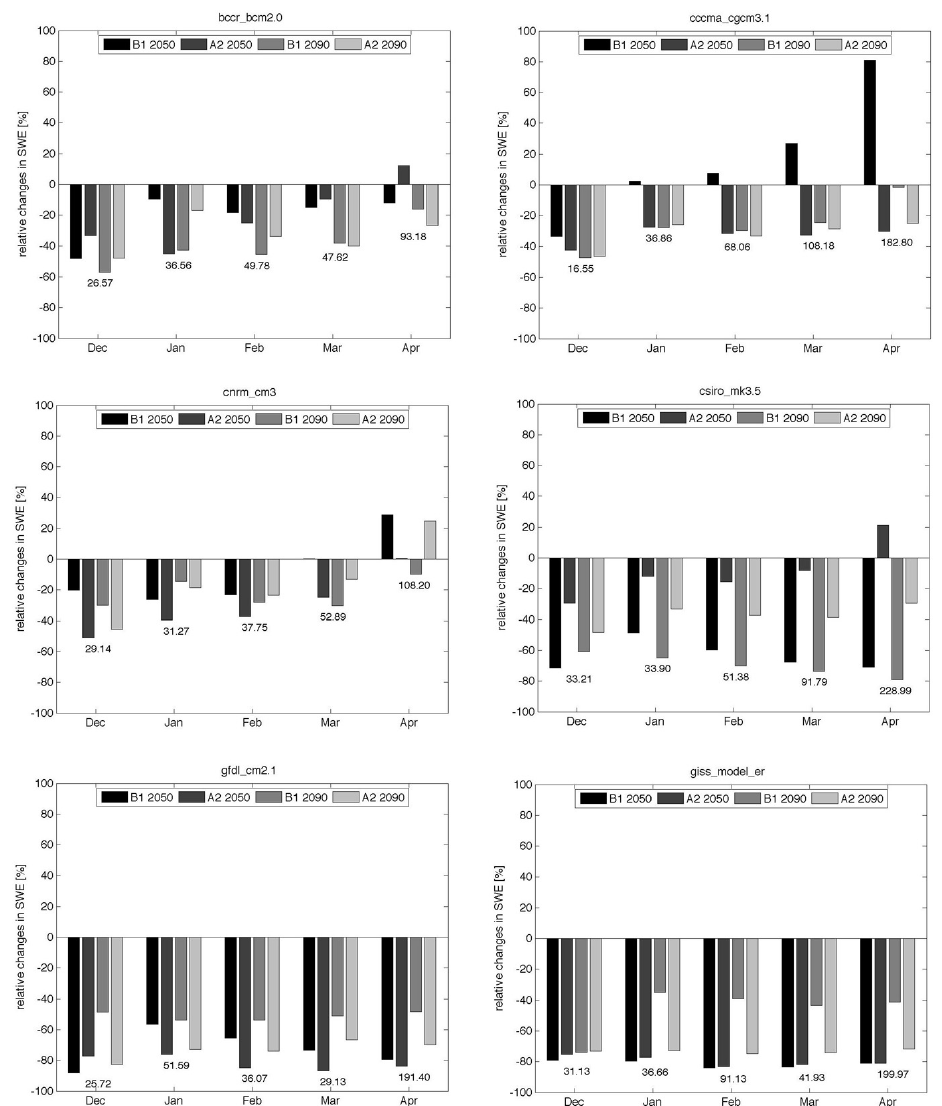
Fig. 8. Changes in basin-averaged SWE relative to baseline conditions (1961–1990) predicted by 12 GCMs for the cold season (DJFMA). Negative values indicate a reduction and positive values indicate an increase in SWE relative to baseline conditions. Also shown are the maximum averaged absolute changes in SWE (in units ofmm/month). The sign of the absolute change must be interpreted with the direction of relative change on the y-axis. Note that only 12 out of 13 models used in the study are